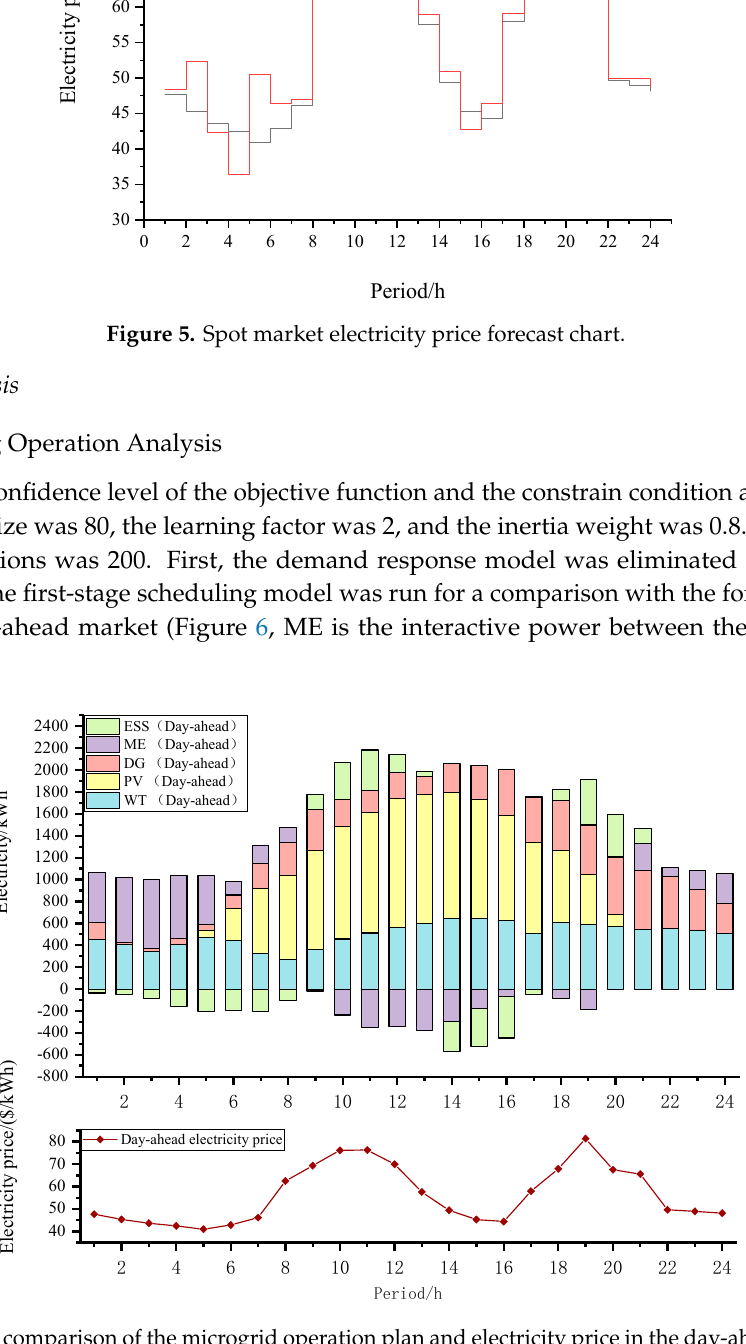
Figure 6. The comparison of the microgrid operation plan and electricity price in the day-ahead market.